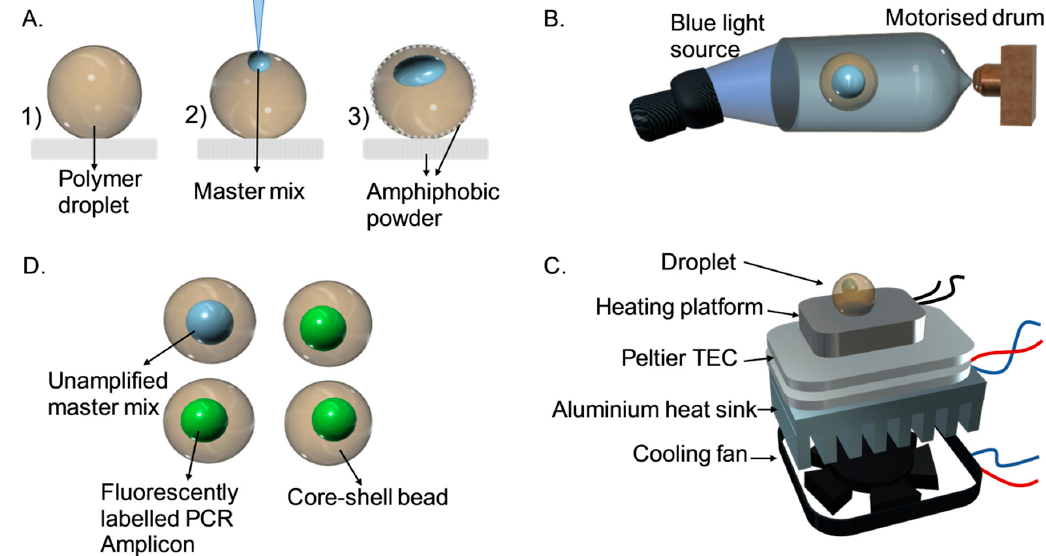
Figure 1. Operation of core-shell-bead-based polymerase chain reaction (PCR). ( A ) (1) Placing a droplet of photopolymer on top of an amphiphobic powder bed. (2) Inserting the PCR solution into the deposited droplet. (3) Covering the droplet with amphiphobic powder. ( B ) Photo polymerization of the droplet under blue light in a drum rotating at 140 rpm. ( C ) Transferring the generated core-shell bead to a custom-built thermal cycler for amplification. ( D ) Discriminating the core shell beads containing amplicons based on fluorescent intensity. Table 1. Primer sequences and sizes of amplicons employed in the phylo-grouping experiment.